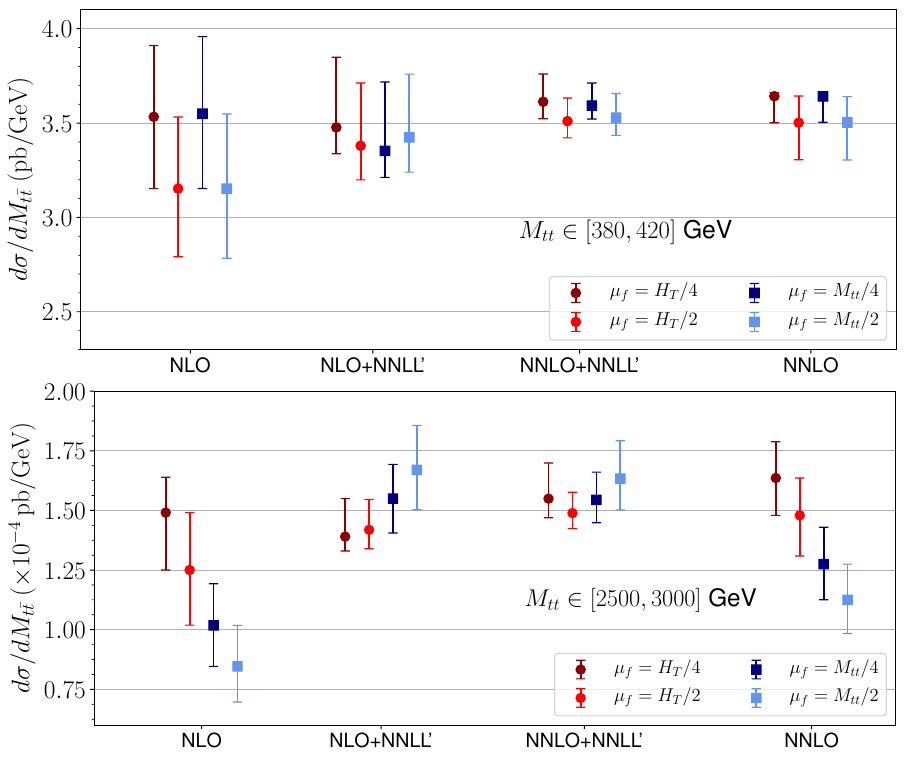
Figure 8 . Cross sections obtained for two sample bins, M 3000] GeV (lower plot). The default value of (cid:22) f is indicated explicitly, and the error M t (cid:22) t = [2500 (cid:0) bars represent perturbative uncertainties estimated through scale variations as described at the beginning of section 5 and in eqs. (5.1) and